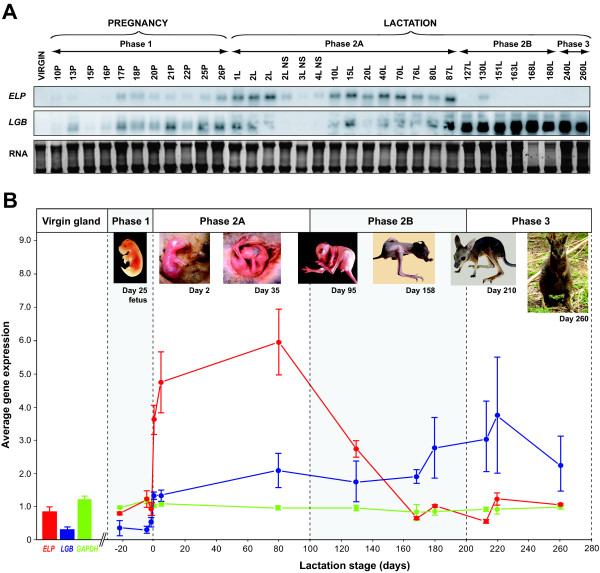
ELPexpression in the tammar mammary gland throughout the reproductive cycle. A. Northern analysis of total RNA (10 μg) extracted from the mammary glands of tammar wallabies during pregnancy (P, Phase 1) and lactation (L, Phase 2A, Phase 2B and Phase 3), from non-sucked (NS) glands and from a virgin female (~220 days of age). Tammar ELP expression was undetected in the virgin gland, minimal during pregnancy (Phase 1) and then induced at parturition and expressed during early lactation (Phase 2A). ELP was down-regulated at mid-lactation (Phase 2B), consistent with [13,20,21]. ELP transcripts were not detected in Phase 3. ELP expression also declined postpartum in non-sucked glands. Tammar LGB was used as a positive control for lactation and exhibited a similar expression pattern to ELP, but with LGB expression increased (but not significantly so) during Phases 2B and 3, as reported previously [13,68,69]. Ribosomal RNA bands indicate RNA integrity and loading. B. Microarray analysis of the tammar mammary gland [ArrayExpress: E-MTAB-1057] supported the quantitative analysis of Northern blot (data not shown) and microarray data reported by [69]. Expression of the ELP and LGB milk protein genes and the housekeeping gene GAPDH (glyceraldehyde 3-phosphate dehydrogenase) is depicted as average normalised raw intensity based upon the expression n = 3, 7 and 2 clones on each microarray respectively ± SEM (Additional file 12: Table S5). Whilst ELP (red) and LGB (blue) expression differed during the reproductive cycle, GAPDH (green) expression was constant.